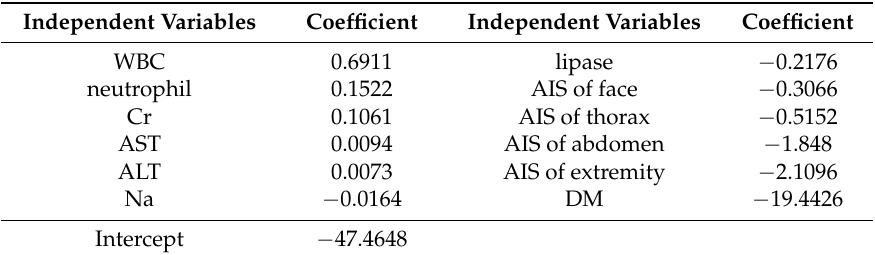
Table 4. Independent risk factors for pancreatic injury in multivariate logistic